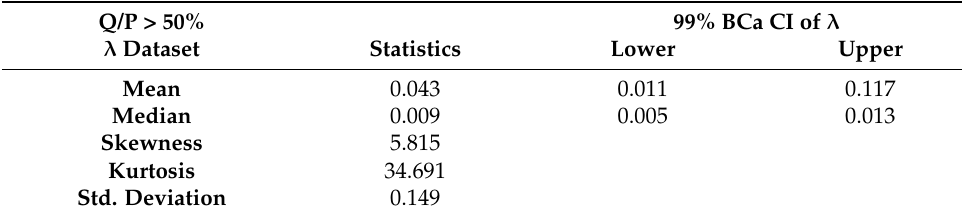
Table 8. Inferential statistics of derived λ at α = 0.01 for Q/P > 60% scenario. Q/P > 60% 99% BCa CI of λ λ Dataset Statistics Lower Upper